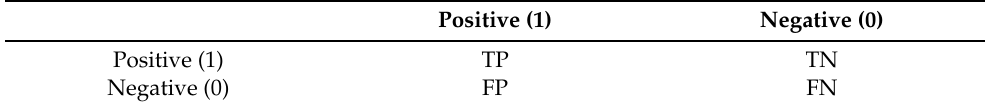
Table 4. Confusion